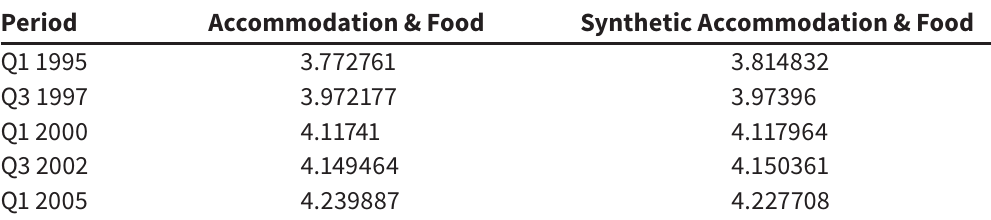
Pre-Treatment Log Employment in Actual and Synthetic Accommodation and Food Industry (Puerto Rican Industry Donors)